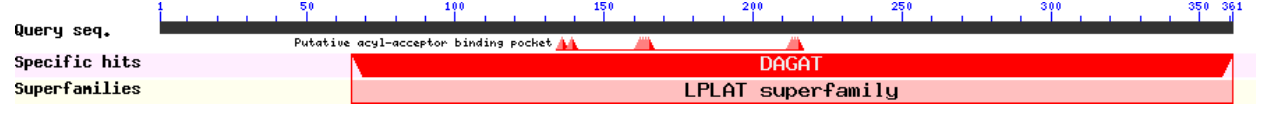
Figure 5. Putative conserved domain of buffalo DGAT2.